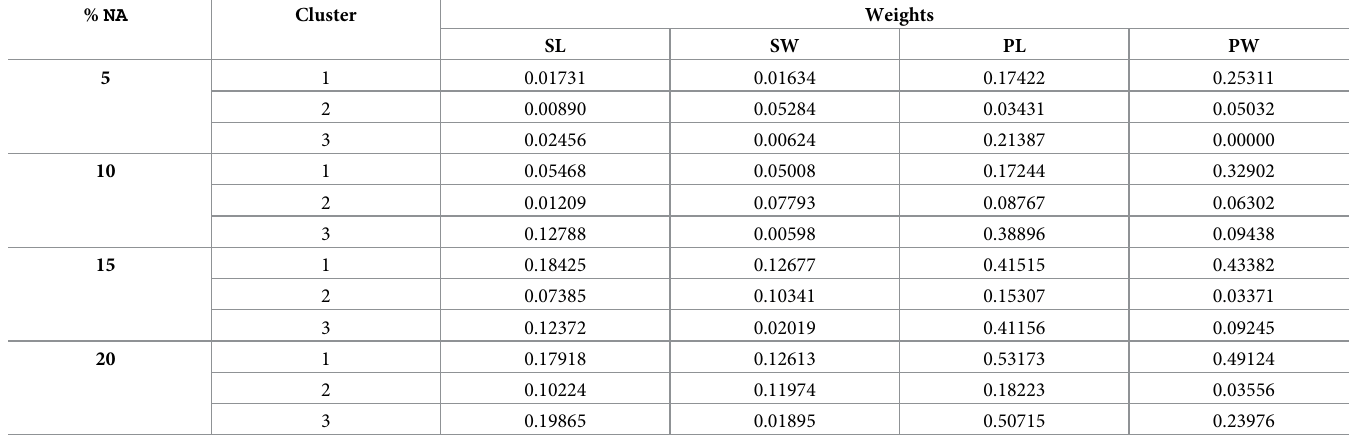
Table 13. Consistency of variables in the VKFCM-K-LP clustering with the imputation of missing values using mean values for the Iris Plant dataset.